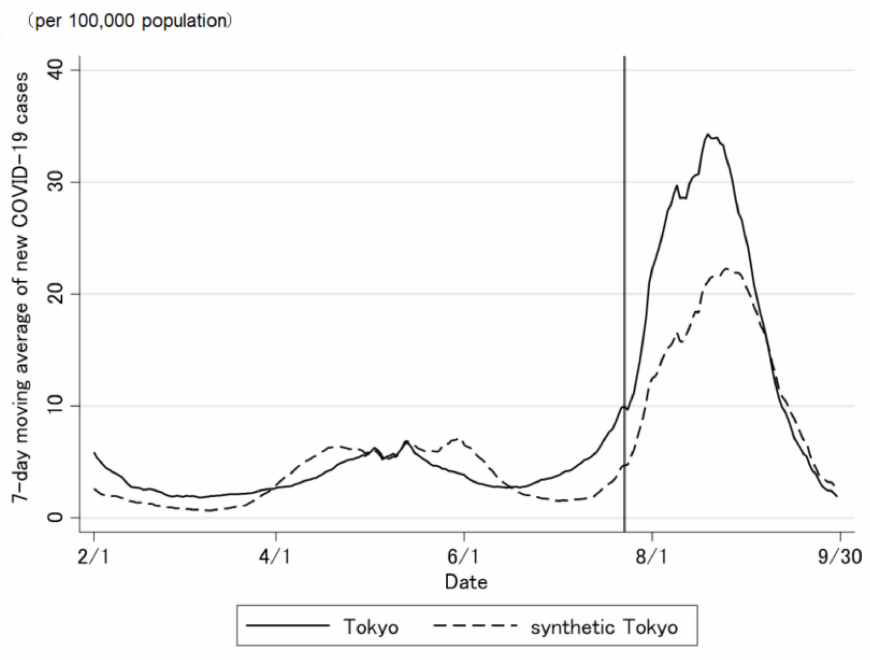
Figure 2. Trends in the daily number of newly confirmed COVID-19 cases in Tokyo and synthetic Tokyo, estimated using synthetic control weights. The vertical line on 23 July 2021 indicates the opening of The Tokyo 2020 Games.